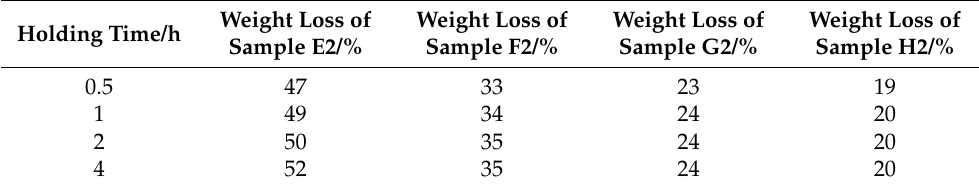
Table 2. Weight loss of sample 2 group under different holding times at 700 ◦